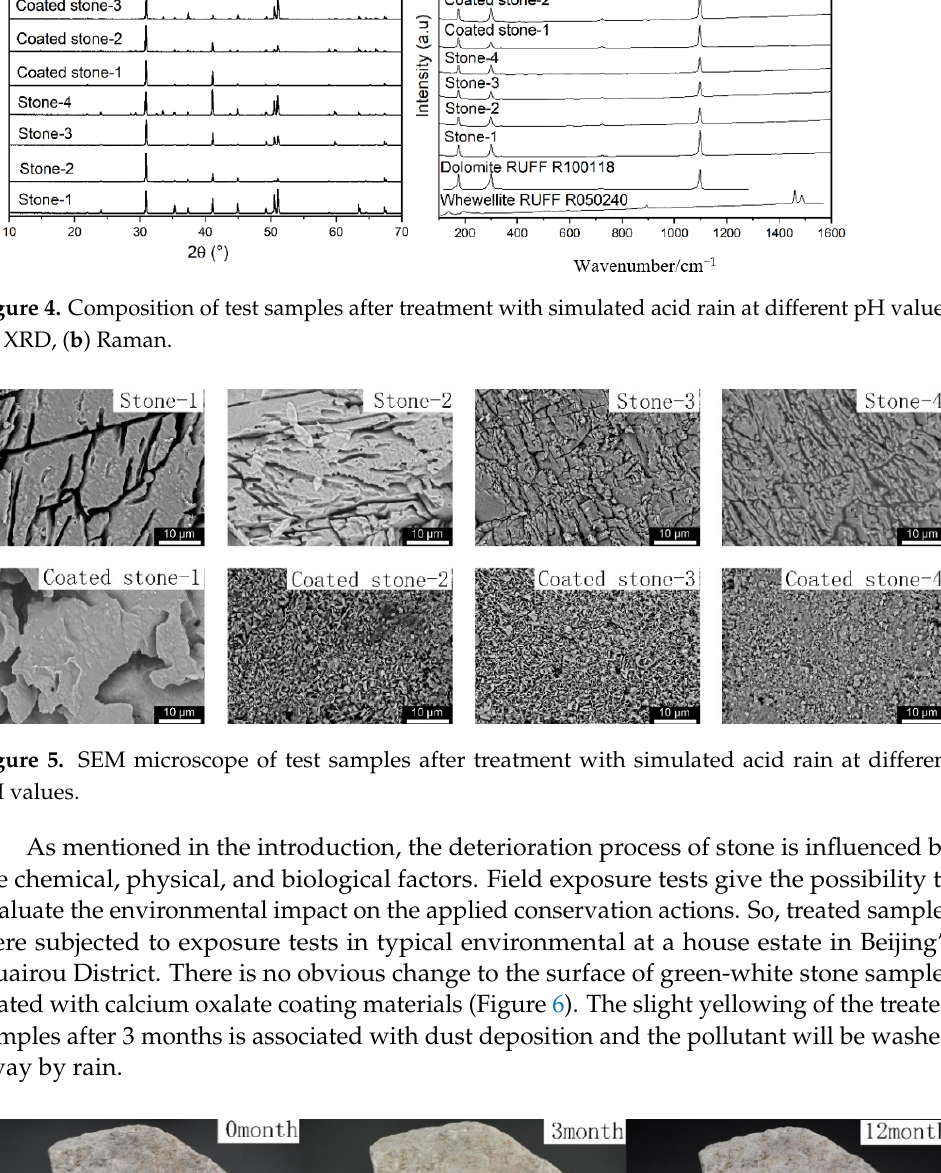
Figure 4. Composition of test samples after treatment with simulated acid rain at different pH val ‐ ues. ( a ) XRD, ( b ) Raman.